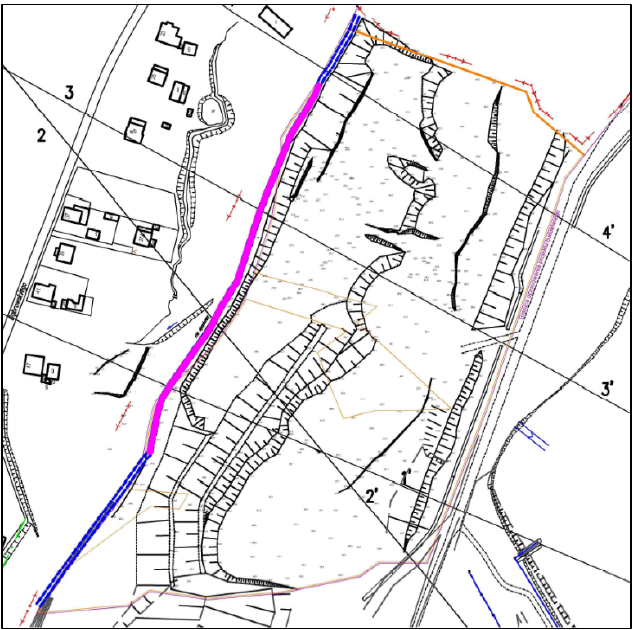
Figure 1. Location of ditch failure with a section of 300 m long, marked in pink.